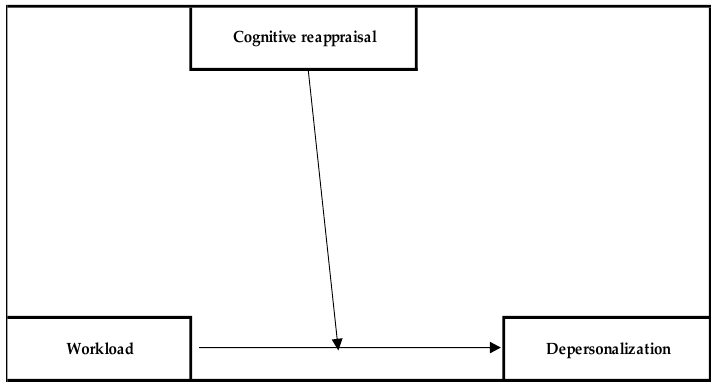
Figure 3. Model 3.